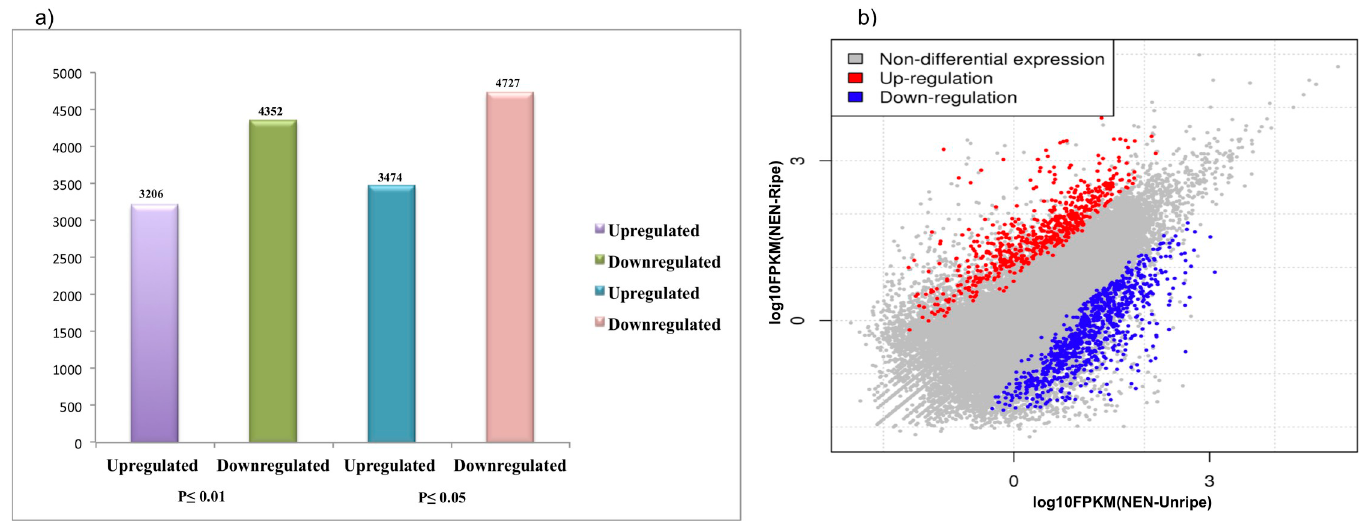
Fig 1. General features of Nendran banana transcriptome. a) Total number of DEGs with p-value � 0.01and � 0.05. b) Scatter plot of all differentially expressed genes. Significant genes with log fold change > 2 are indicated by red color and those having log fold change < 2 are indicated by blue color, while genes without significant difference are depicted by grey